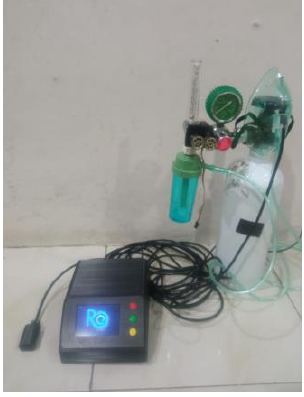
Figure 14 . System integration.